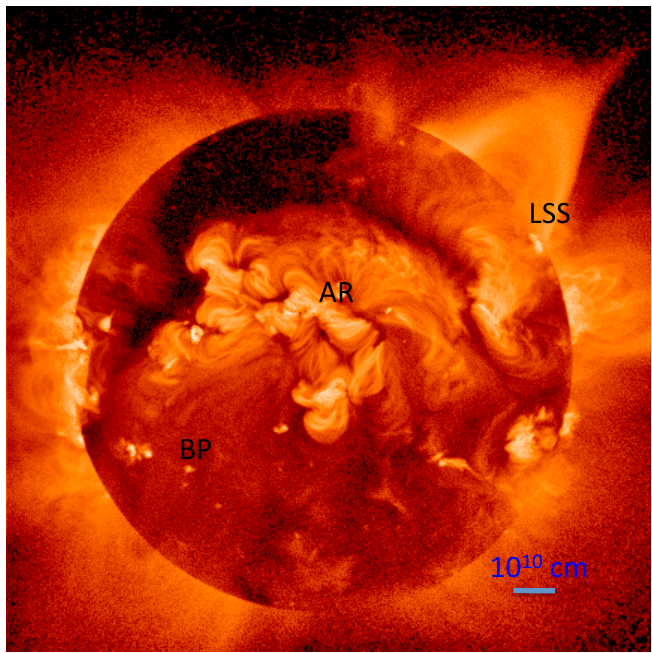
Figure 2: The X-ray corona contains loops with different spatial scales, e.g., bright points (BP), active region loops (AR), large-scale structures (LSS). The scale unit is labelled. Image credit: Yohkoh mission, ISAS,